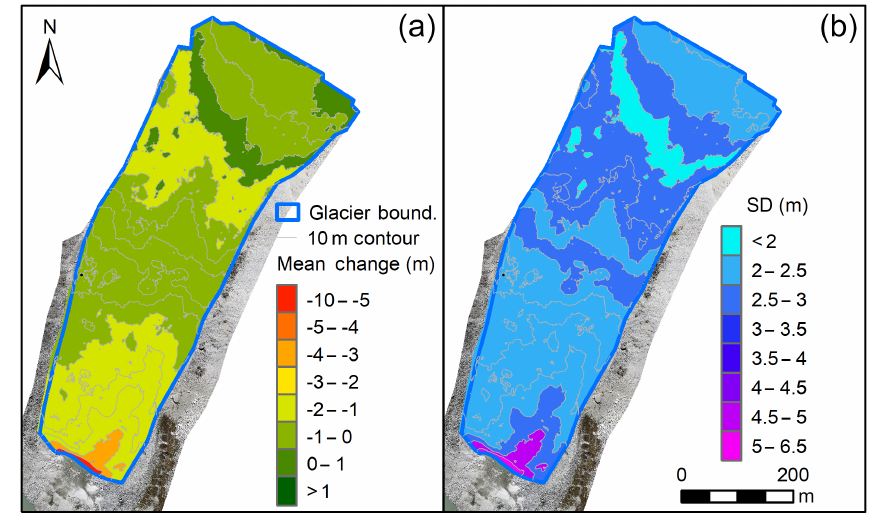
Figure 12. Changes in glacier tongue elevation by 10m elevation band. (a) Mean elevation change within a 10m elevation band. (b) SD of elevation change within a 10m elevation